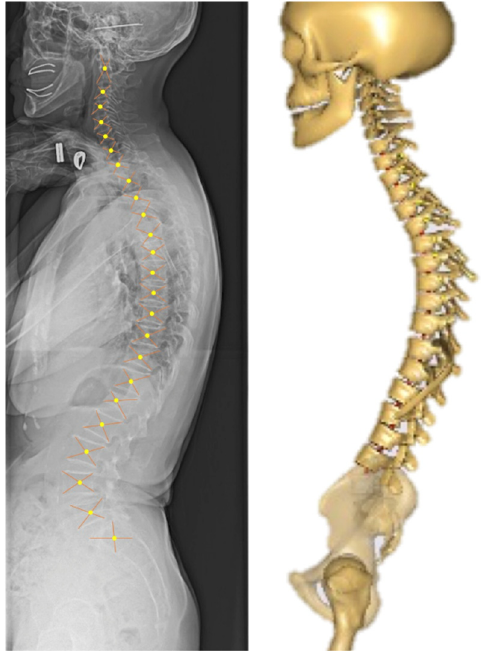
Figure 3. Defining the center of the vertebral body and modified musculoskeletal model. The musculoskeletal model was modified according to the sagittal spinal alignment of the patient.